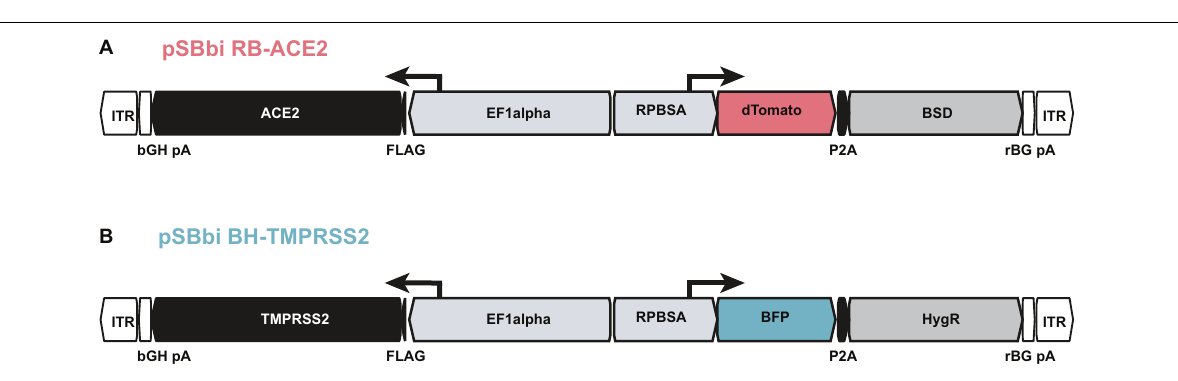
FIGURE 3 | Constructs used for the generation of A549-AT model cells. Schematic drawing of plasmids (A) pSBbi RB-ACE2 and (B) pSBbi BH-TMPRSS2 including locations of open reading frames (ORFs), transcriptional start sites of the promoters (EF1alpha, RPBSA), inverted terminal repeats (ITR), polyadenylation signals (pA), FLAG epitope (FLAG), 2A self-cleaving peptide (P2A). ACE2 and TMPRSS2 ORFs are marked in black. The ORFs encoding dTomato and BFP are highlighted in red and blue, respectively. The antibiotic resistance cassettes coding for blasticidin S deaminase gene (BSD) and the Hygromycin resistance gene (HygR) are indicated in